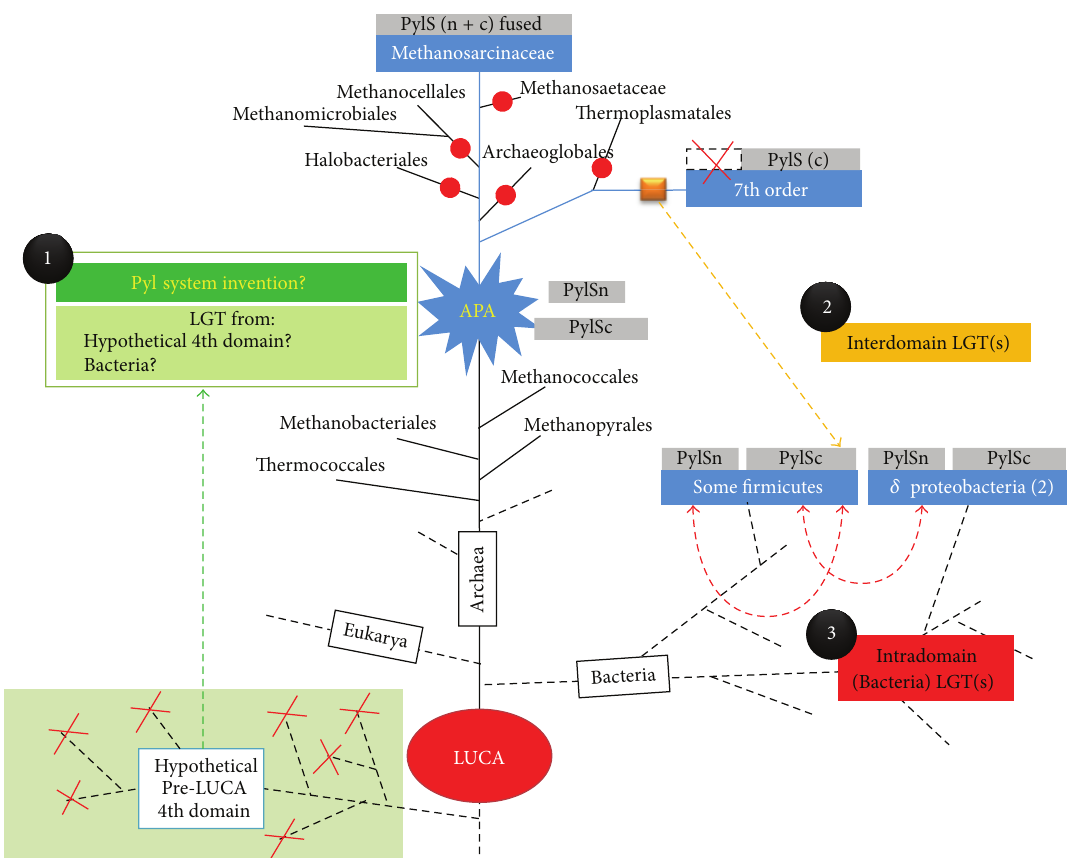
Figure 4: Proposed scenarios for the origin and evolution of the pyrrolysine system. One of the various possible models leading to the genesis of APA, the ancestral Pyl-coding archaeon, is schematized. This model supports less LGTs than previously proposed ones. APA (blue star) emerged in the Euryarchaeota (black circle no. 1) after the birth of the methanogenesis and was an ancestor of the Methanosarcinalesand/or of the Thermoplasmata-related 7th order of methanogens. Only the hypothesis of a common ancestor of both Methanosarcinalesand Thermoplasmata-related 7th order of methanogens is depicted here (see text for an alternative model with APA as a more recent ancestor, of the Methanosarcinalesor of the Thermoplasmata-related 7th order of methanogens, but not both). The putative genesis of APA (green boxes) relies either from an archaeal invention (Box 1), from a bacterial contribution, or from a whole functional system acquired from a hypothetical pre-LUCA 4th domain of life. APA was therefore likely a methanogenic archaeon performing both a methanol-H 2 -dependent methylotrophic methanogenesis and a hydrogenotrophic one. The Pyl system was vertically inherited (symbolized by large blue lines) to Methanosarcinaceae and to the 7th methanogenic order and was lost several times independently on various branches, including methanogenic ones (red dots). Due to the closest relationship of the Pyl system (orange square) between the 7th order and bacteria, at least one LGT is supposed to have occurred from a 7th order ancestor (before the loss of the pylSc gene in this lineage), likely to a Firmicute(no. 2, orange arrow). Other LGTs from the 7th order to Bacteria (i.e., a deltaproteobacterium) are also conceivable. In a third period, intradomain LGT(s) could have originated next putatively among Firmicute and/or into a deltaproteobacterium (no. 3, red arrows). Pyl-coding organisms are symbolized in blue boxes. The nature of the PylRS is depicted with each Pyl-containing group in grey boxes and is either formed by a unique PylS (Methanosarcinaceae), a split complete version (PylSc//PylSn in bacteria), or a unique PylSc form (7th methanogenic